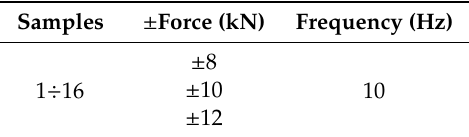
Table 7. Applied forces for fatigue